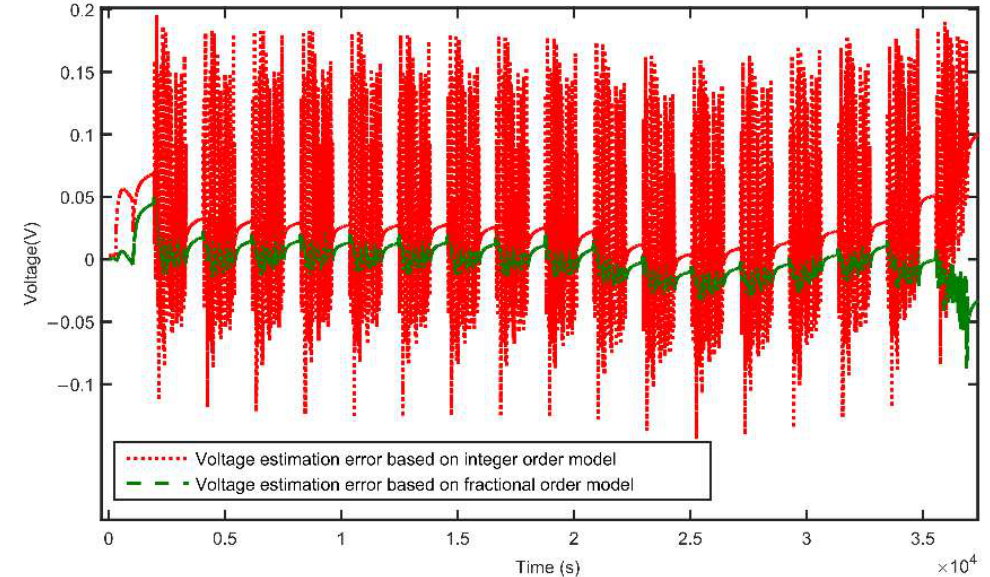
Figure 29. Comparison of voltage estimation error based on fractional-order model and integer- order model.